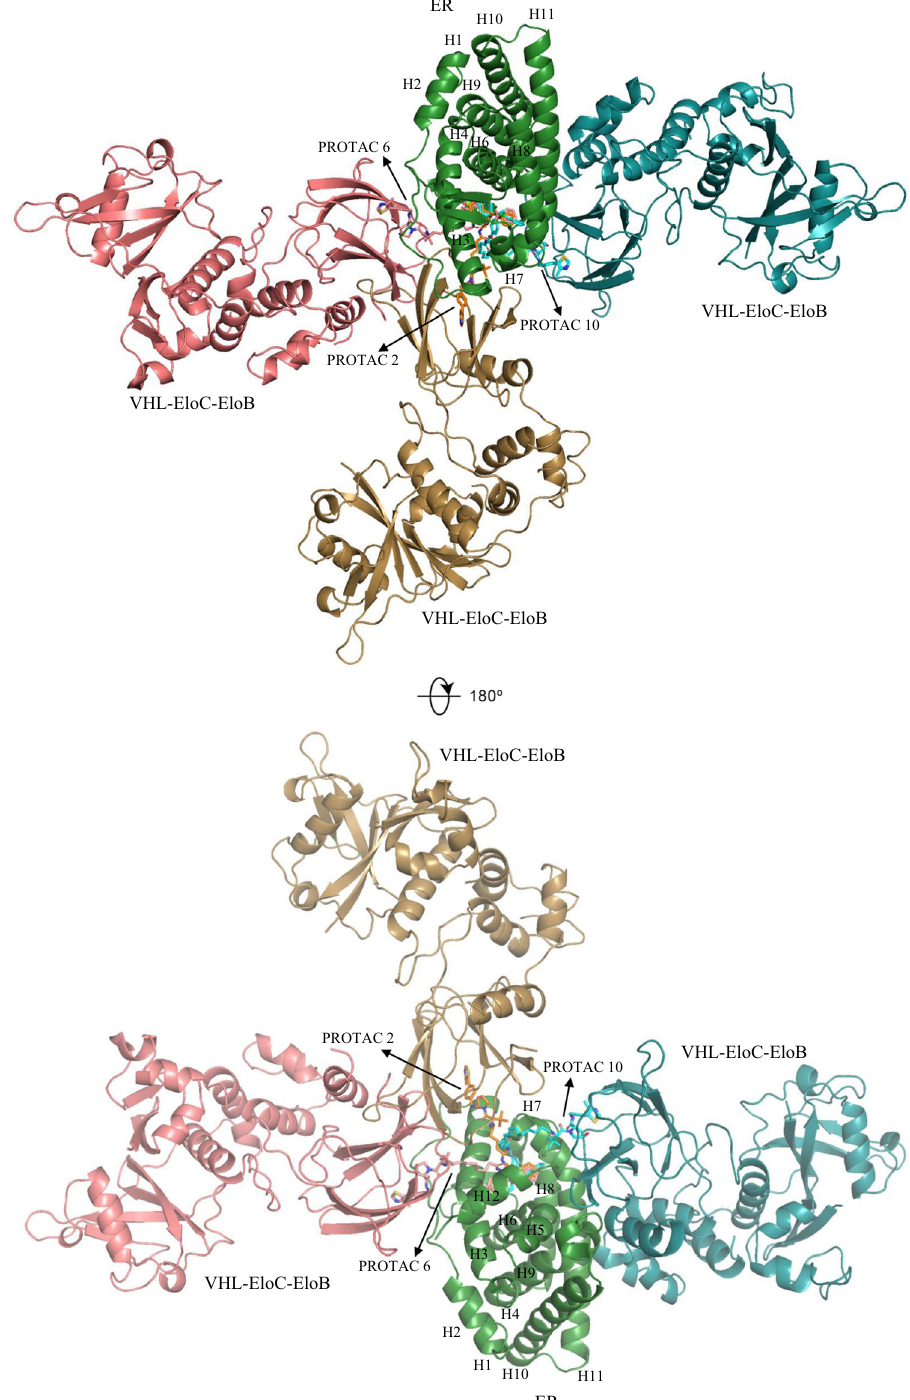
Fig. 7 | Computational models of ternary complexes constituted by ER, VHL- EloC-EloB and PROTACs (PROTAC 2, 6, and 10) from two views. All models are aligned based on the position of ER protein (green). The VHL-EloC-EloB